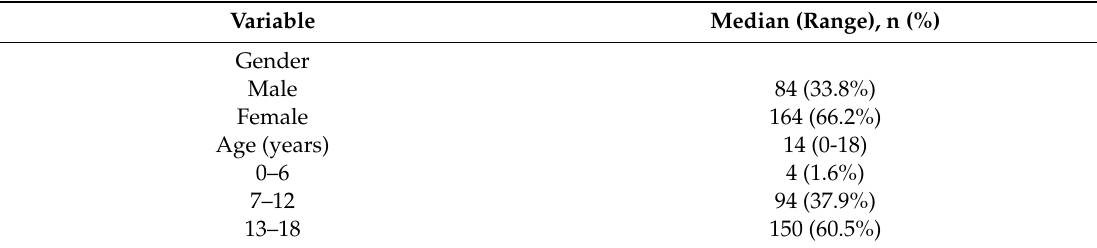
Table 1. Patients’